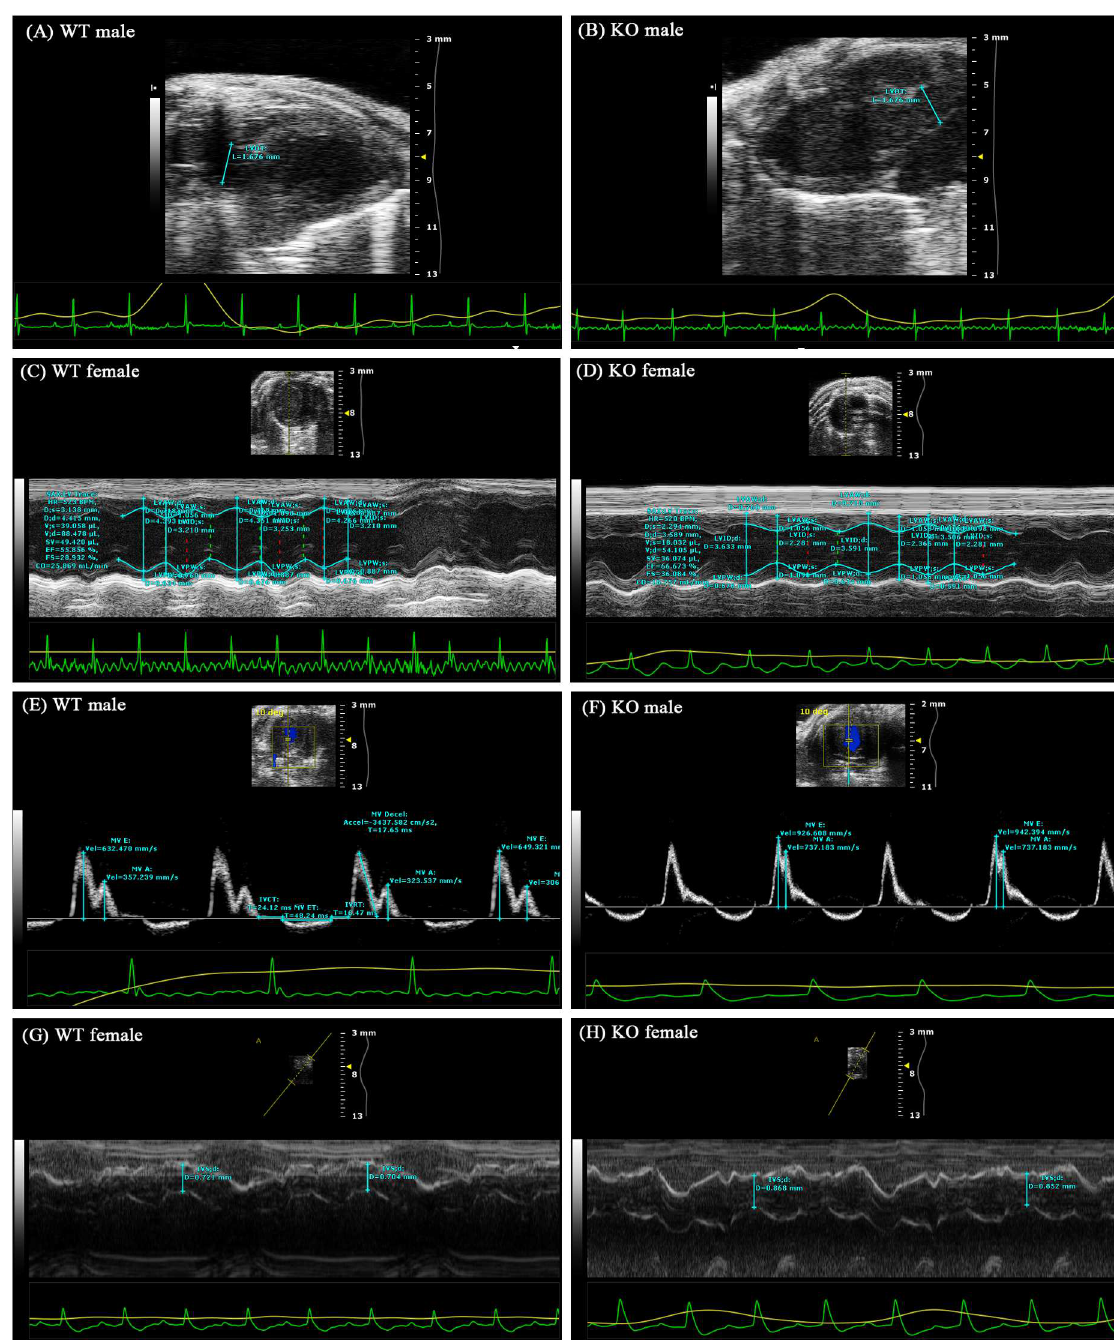
Fig 3. Representative echocardiography parameters. Cardiac functionswere evaluatedby echocardiography.(A and B) Lengthof the left ventricular outflow tract (LVOT); (C and D) Measurement and recordingof the left ventricular short axis view; (E and F) Ventriculardiastolic function detection: the ratio of the peak E and A wave velocitiesof the mitral valve rheography (E/A); and (G and H) IVS depth. The parameters showedno significantdifferences in the main evaluationindices. (Mice were 8 weeks